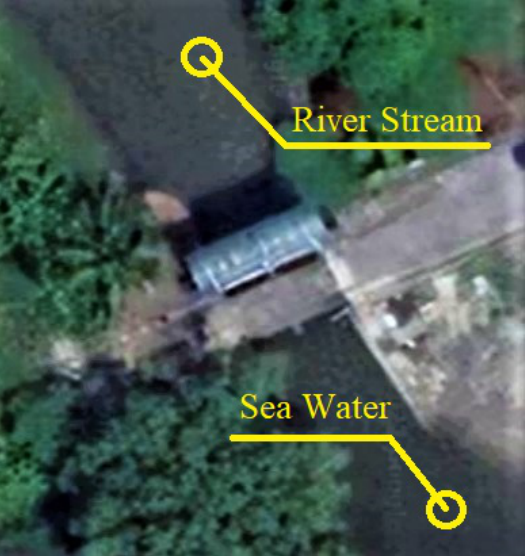
Figure 5. Satellite view of the physical measurement